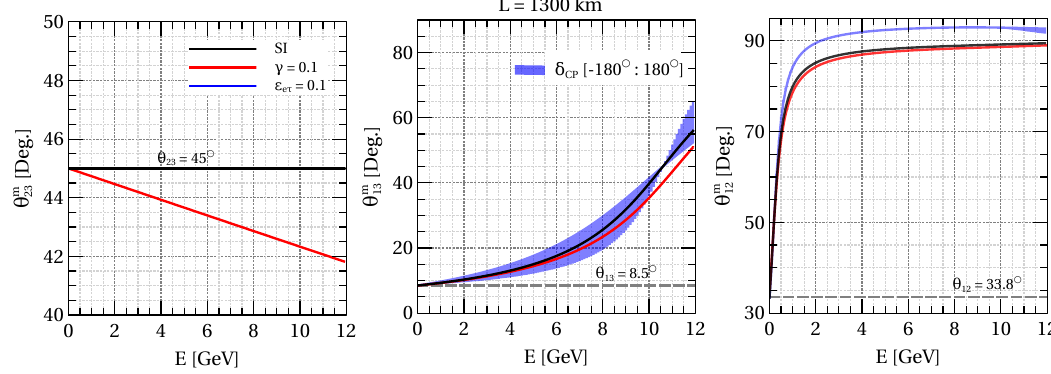
(left panel), θ m (middle panel), and θ m Figure 16 . Evolution of three modified mixing angles θ m 23 13 12 (right panel) as a function of neutrino energy [see eqs. (B.1) to (B.7)] for the SI case (black curves) and SI+NSI cases considering the NSI parameters γ (red curves) and ε (blue curves) with strength eτ 0.1 for the baseline of 1300 km. θ m does not evolve in the SI case and with the NSI parameter 23 ε eτ (see the left panel where black and blue curves completely overlap with each other). In the middle and right panels, the blue colored bands are obtained by varying δ in the range of − 180 ◦ CP to 180 ◦ with ε = 0 . 1 . Note that the evolution of θ m does not depend on δ at all, whereas the eτ CP 23 evolution of θ m and θ m do not depend on δ for the SI case and with the diagonal NSI parameters CP 13 12 γ . Values of the benchmark oscillation parameters in vacuum are taken from table 2 with θ 23 = 45 ◦ assuming